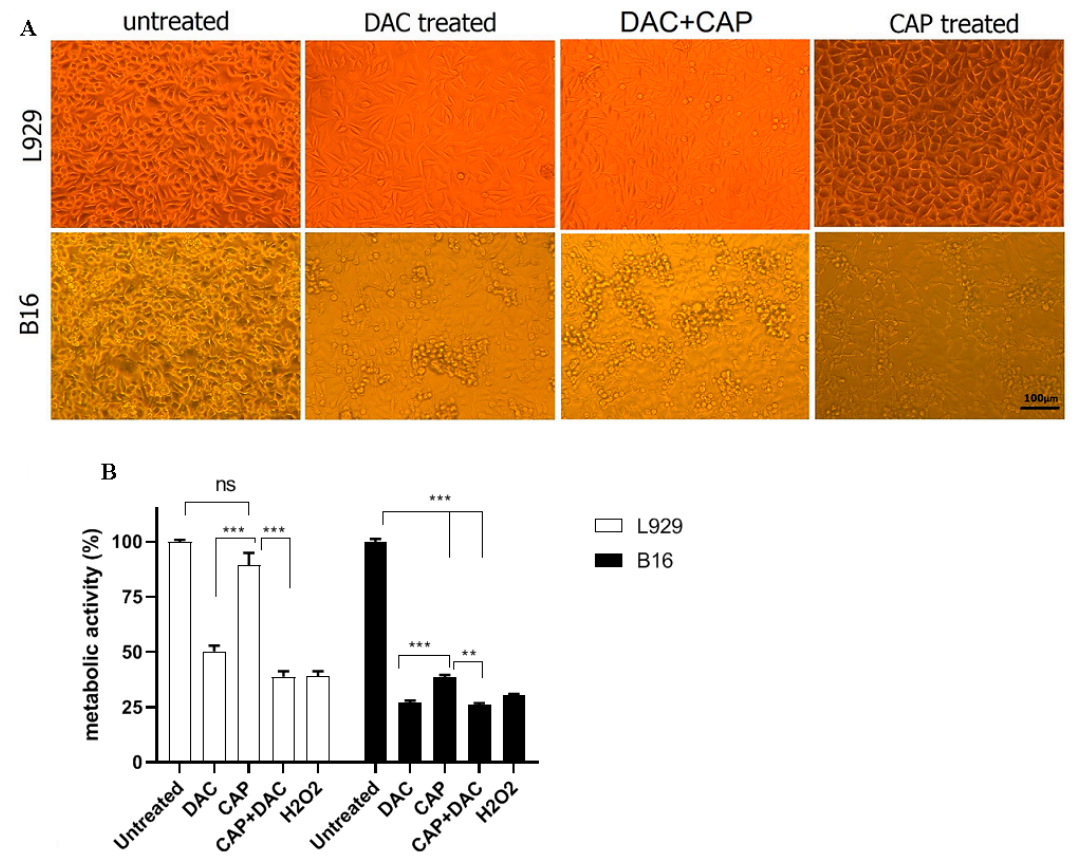
Figure 2. The e ff ect of CAP, DAC, or combined treatment on cell morphology and metabolic activity of B16 and L929 cells.The cells were treated with CAP for 45 s, DAC (100 µ g / mL), CAP + DAC combination, or were left untreated, and evaluated after 24 h. ( A ) Metabolic activity was assessed at 24 h post-treatment using the MTT assay. ( B ) Since ROS production is a well-defined mechanism of plasma, hydrogen peroxide was used as a positive control. The results are representative of mean + SD of three independent experiments. Metabolic activity was calculated by the below formula: (OD 570nm of treated cells / OD 570nm of untreated cells) × 100. The scale bar is 100 µ m. NS means not significant, and *** and ** represent p < 0.001 and p < 0.01, respectively.